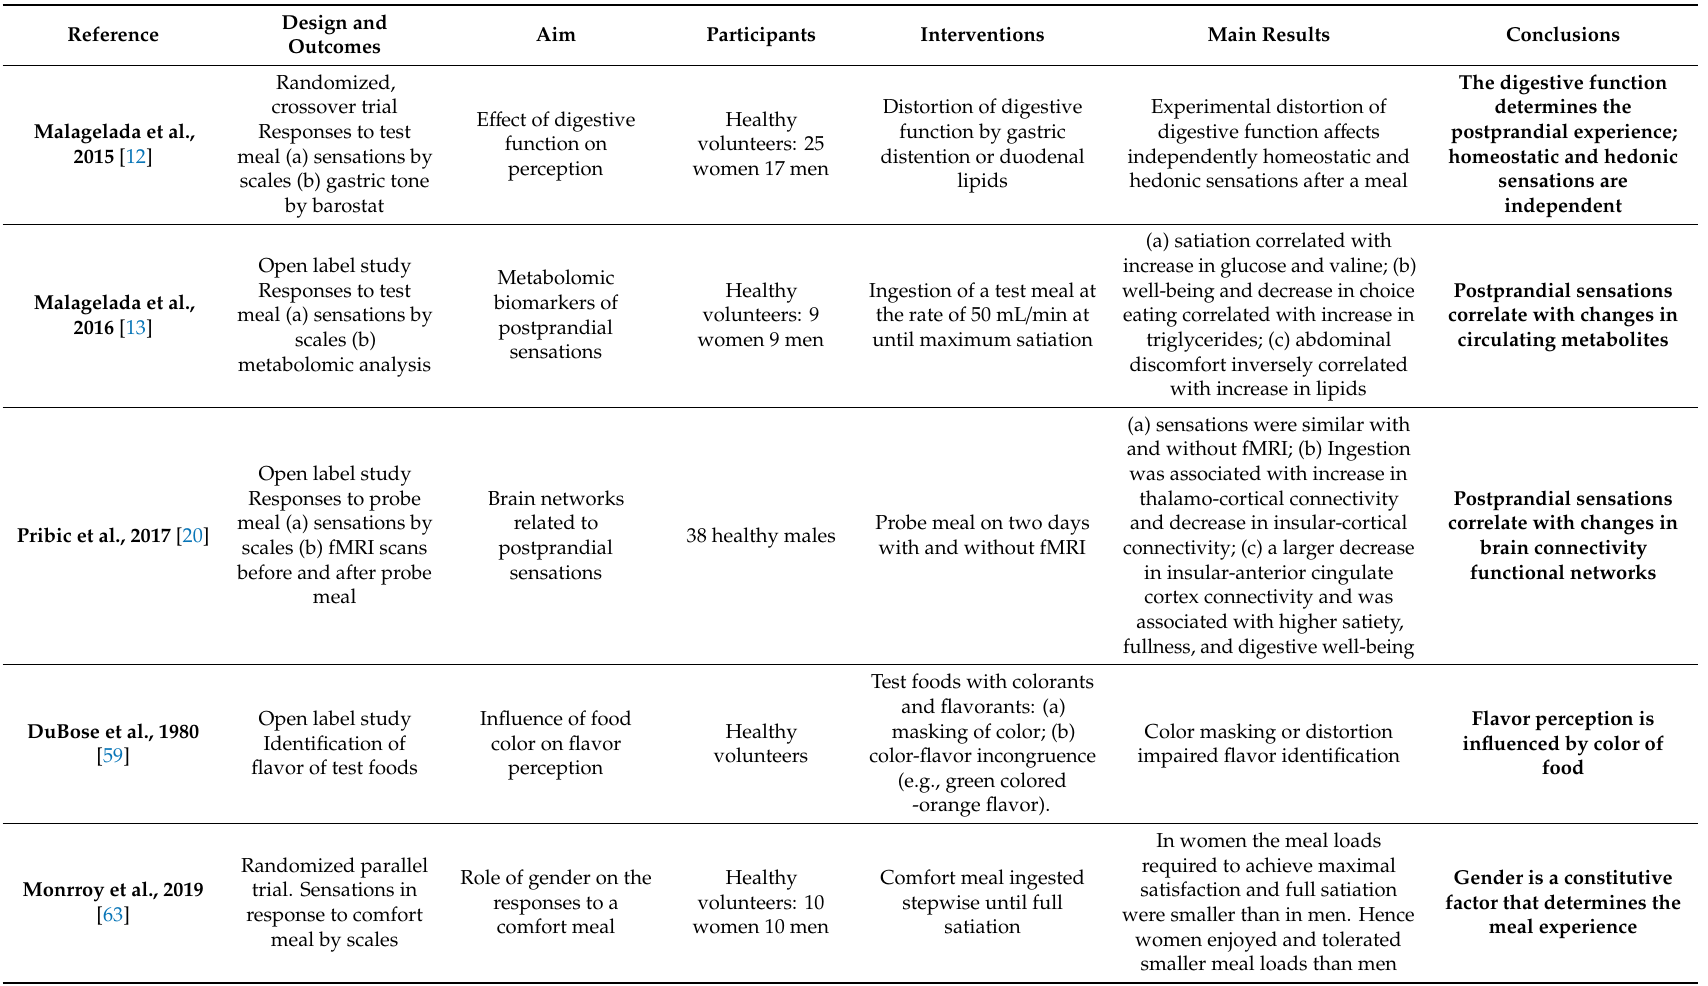
Table 1. Factors that influence the postprandial experience: previous